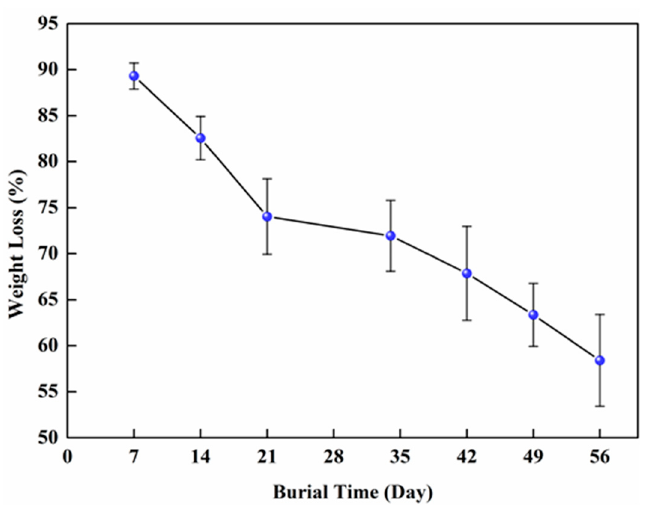
Figure 2. Weight loss of environment-friendly bamboo fiber lunch box in different degradation stages.